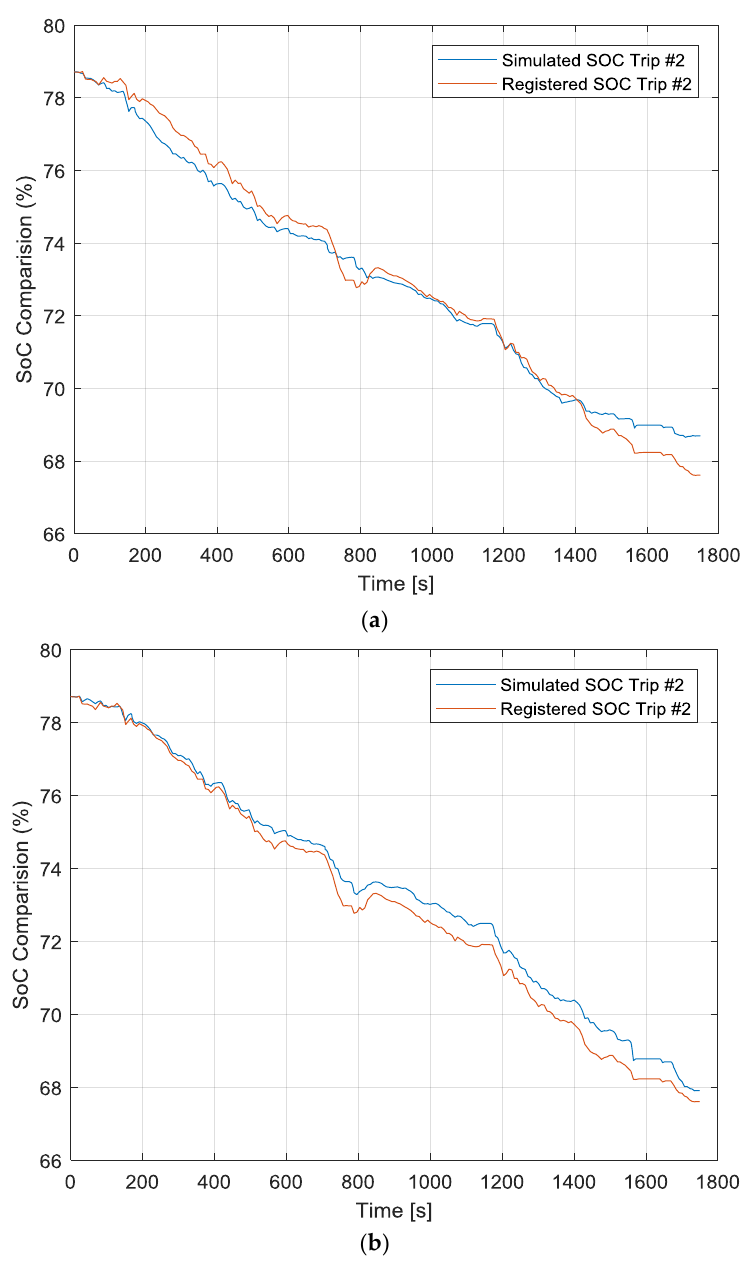
Figure 13. Trip #2 ( a ) Driving events, shown in Figure 11, are not considered in this simulation ( b ) Driving events are considered.